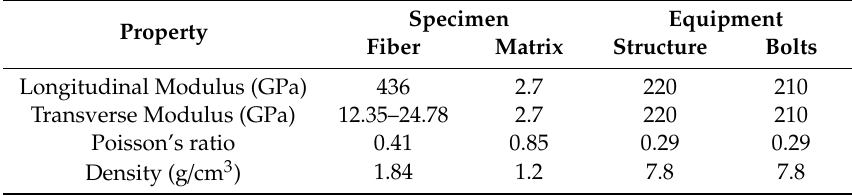
Table 1. Material properties of the composite specimens and steel equipment.